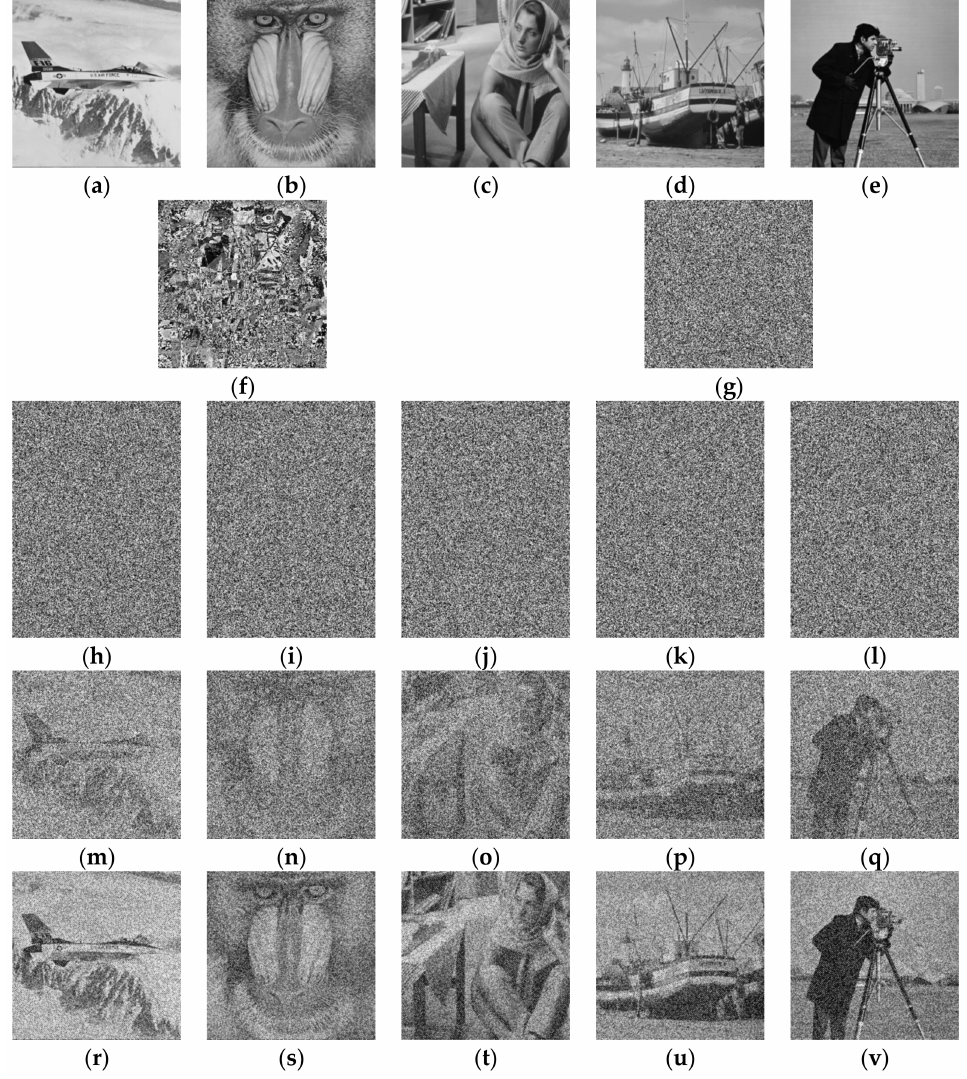
Figure 6. A (5, 4, {2, 3, 4, 5}) XOR-based progressively secret image sharing example, ( a – e ) the secret images, ( f ) XOR result of ( a – e ), ( g ) the generated random image, ( h – l ) shared images, ( m – q ) recovery results by using ( h – i ), ( r – v ) recovery results by using ( h – j